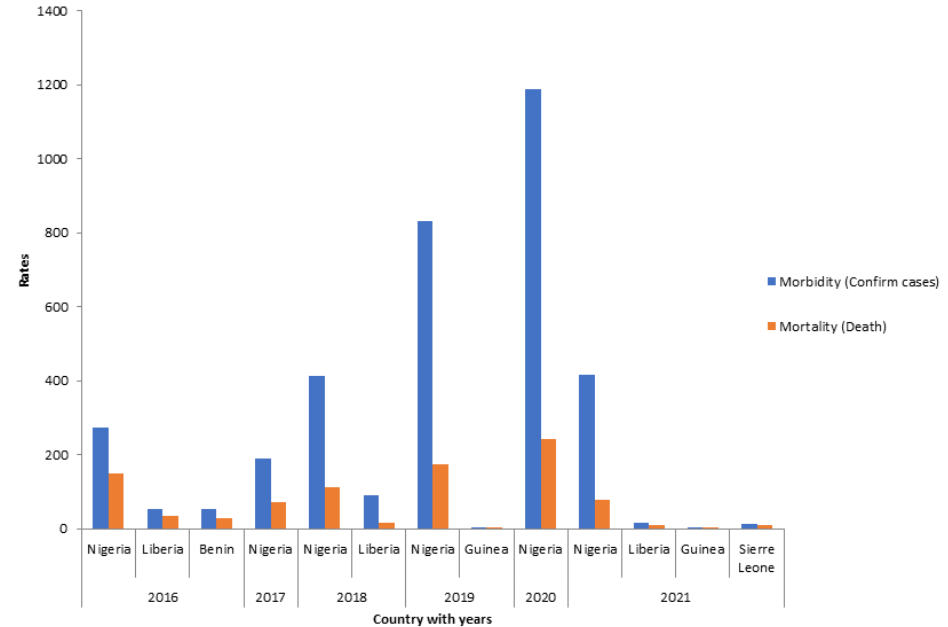
Figure 1. Morbidity and mortality rate in West Africa from 2016–2021